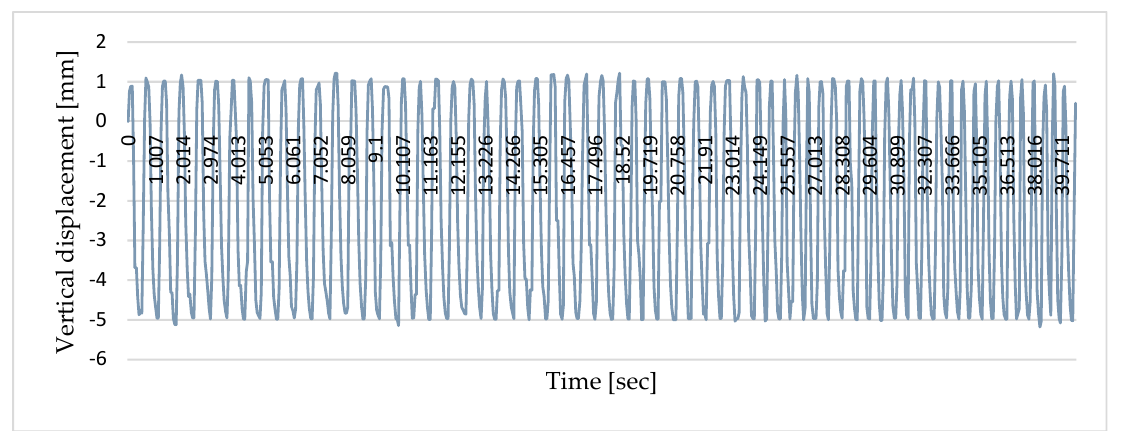
Figure 12. Geodetic measurement equipment. (A) Geodetic measurement point; (B) Leica TS50; (C) personal computer with GeoCOM/ZG software.